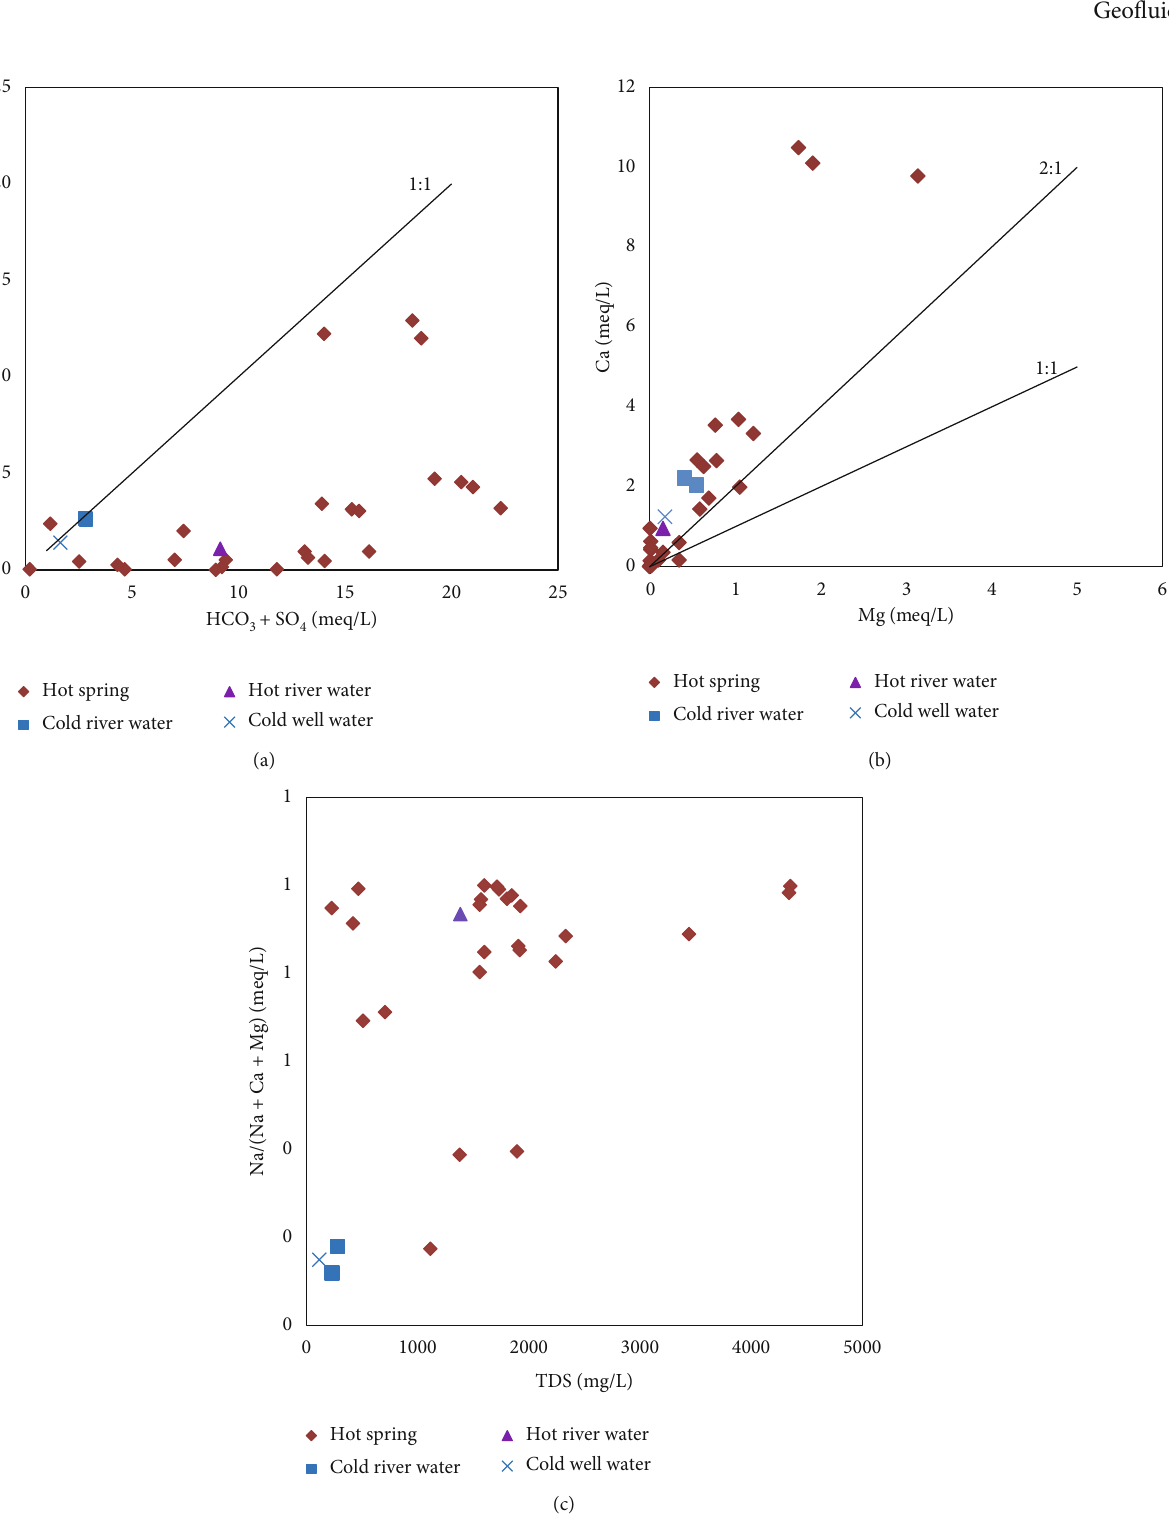
Figure 3: Ratio diagrams of the ions of water samples in the study